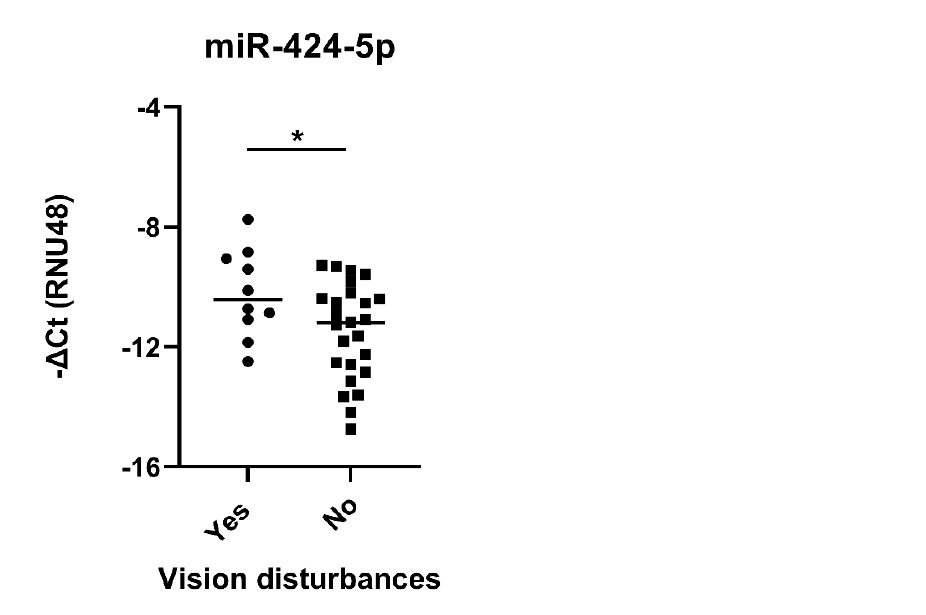
Figure 4. Increased expression of miR-424-5p in histologically positive TABs from GCA patients with vision disturbances. Normalized expression of miR-424-5p in 35 histologically positive TABs from GCA patients with or without vision disturbances. miR expression was calculated as negative delta Ct ( − ∆ Ct) of individual miRs normalized to the RNU48 expression. Line represents the median miR expression in each patient group. * p < 0.05. Legend: GCA, giant cell